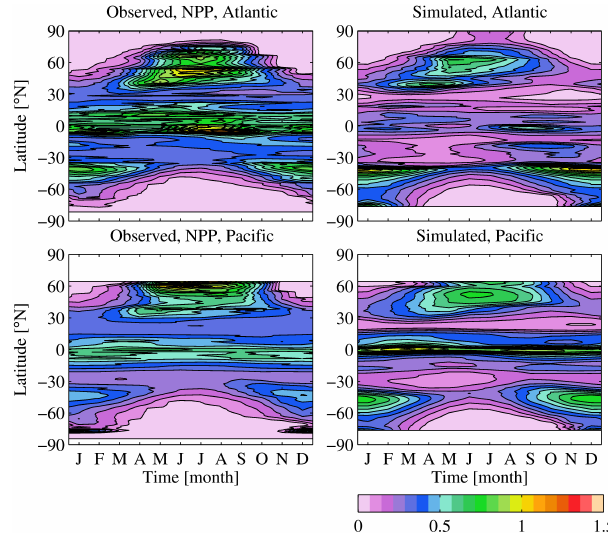
Fig. 14. Hovm¨oller diagrams of observational (left) and simulated (right) monthly integrated primary production, averaged zonally for the Atlantic (top) and Pacific (bottom) basins. Production in g C m − 2 d − 1 .